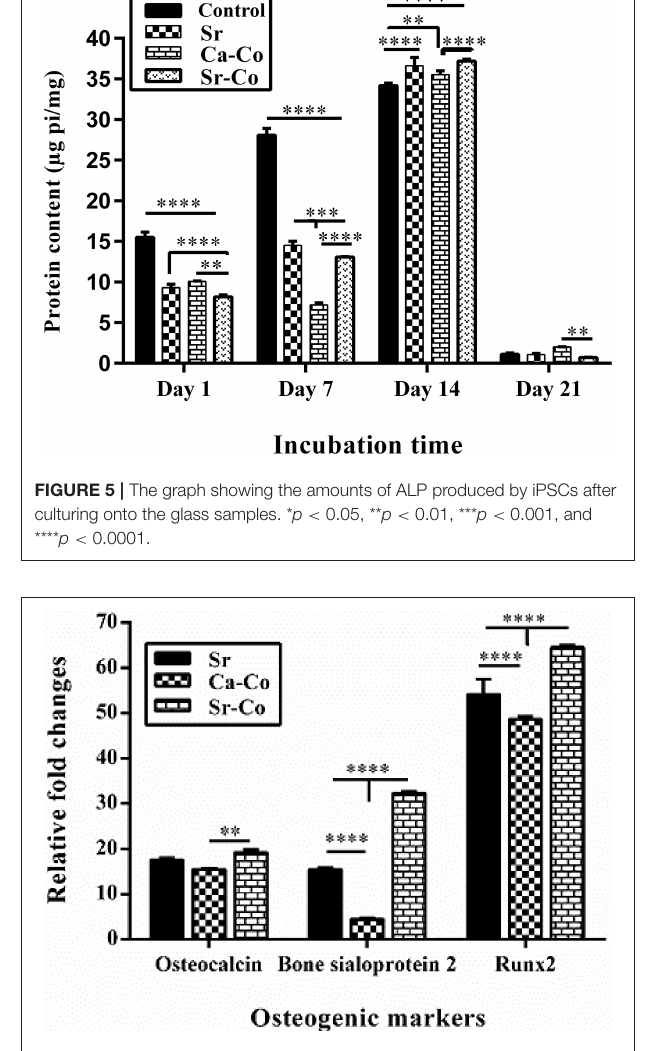
FIGURE 6 | The results obtained from qRT-PCR showing the effect of the BGs on the expression of osteogenesis markers after 21 days’ post-incubation. The data were evaluated in triplicate and collected from three independent experiments. The mRNA expression levels were normalized to GAPDH in each cell line. * p < 0.05, ** p < 0.01, *** p < 0.001, and **** p <